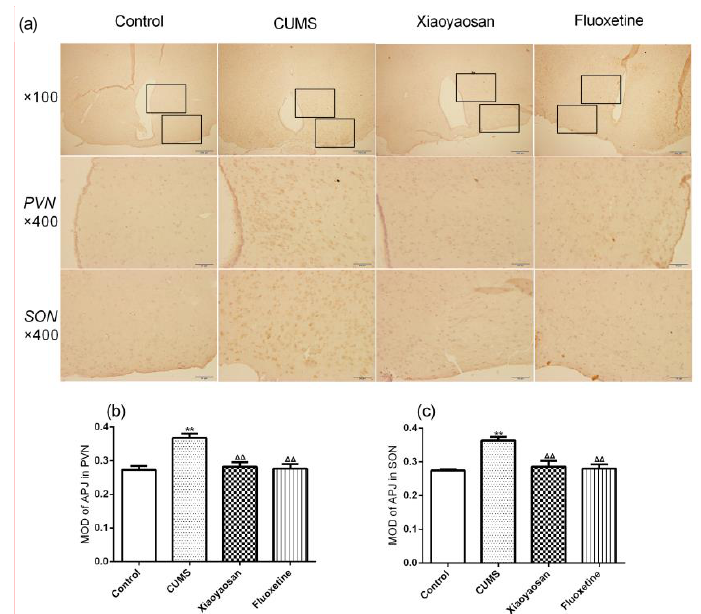
Figure 7. ( a ) Representative micrographs of immunohistochemical staining for APJ (scale bar = 50 μm, 400× magnification) in the PVN and SON; ( b ) The result of image analysis of APJ in PVN; ( c ) The result of image analysis of APJ in SON. MOD, mean optical density. Data were expressed as means ± SEM ( n = 5), ** p < 0.01 versus control group; ΔΔ p < 0.01 versus CUMS group.